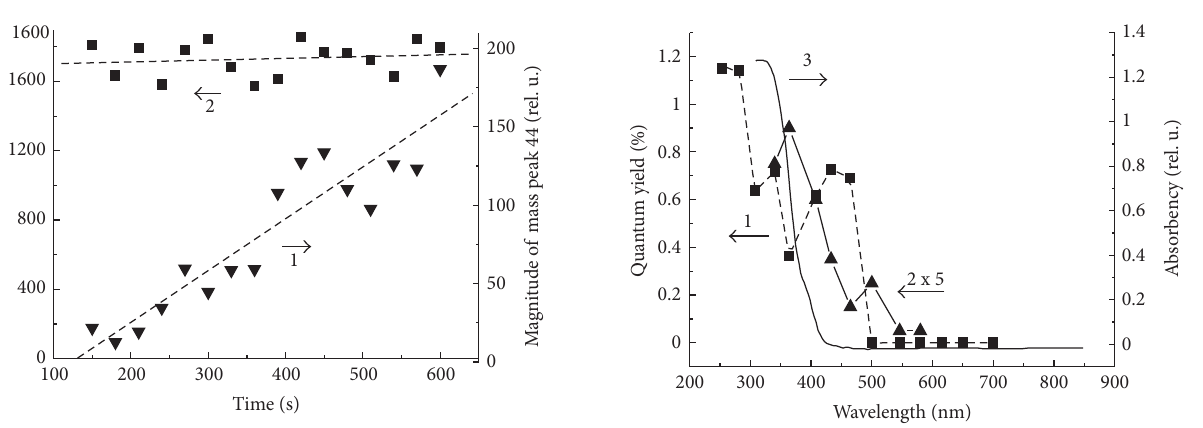
(Figure 6, curve 1). e spectral dependence of 2